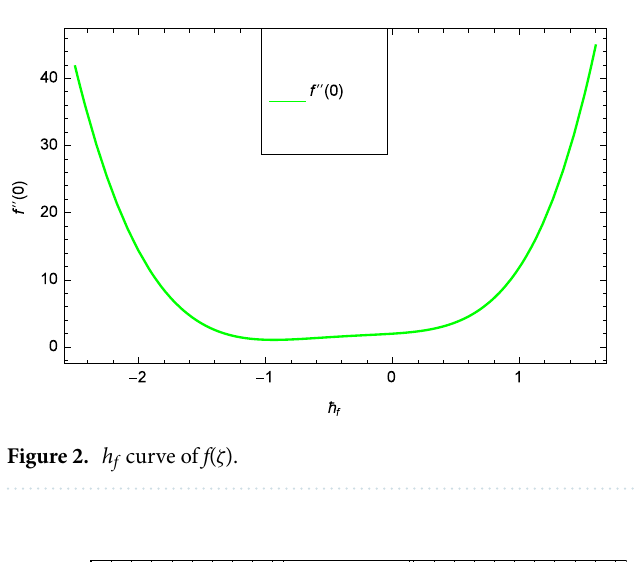
Figure 2. h f curve of f ( ζ ).